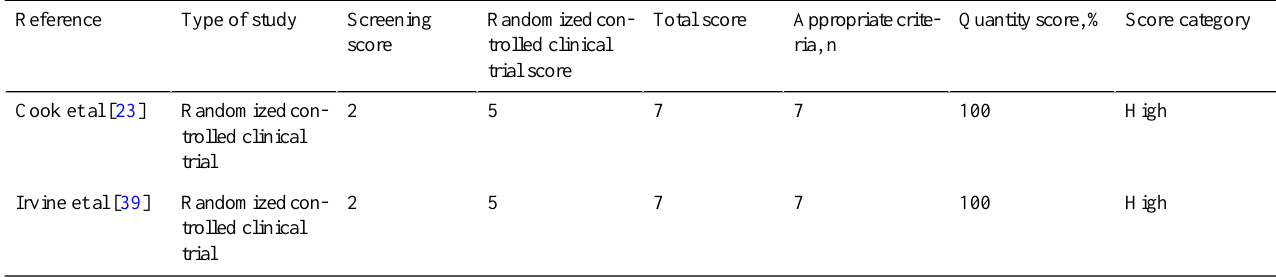
Table 2. Quality score of the selected studies.